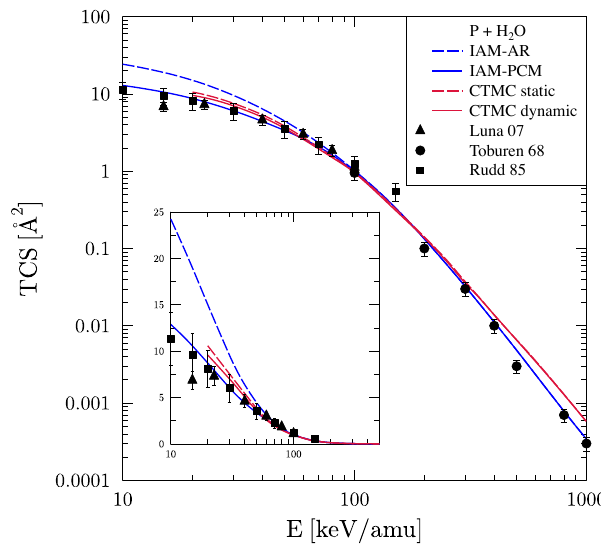
Figure 2. Net electron capture cross section for proton-water collisions. The highest curve (dashed blue) shows the Bragg additivity rule result (IAM-AR), the lowest (solid blue) curve the IAM-PCM result. In between are the classical-trajectory Monte Carlo (CTMC) results, namely the (dashed red) static-potential CTMC, and below it (solid red) the dynamical-screening CTMC result. The experimental data are from References [31–33].